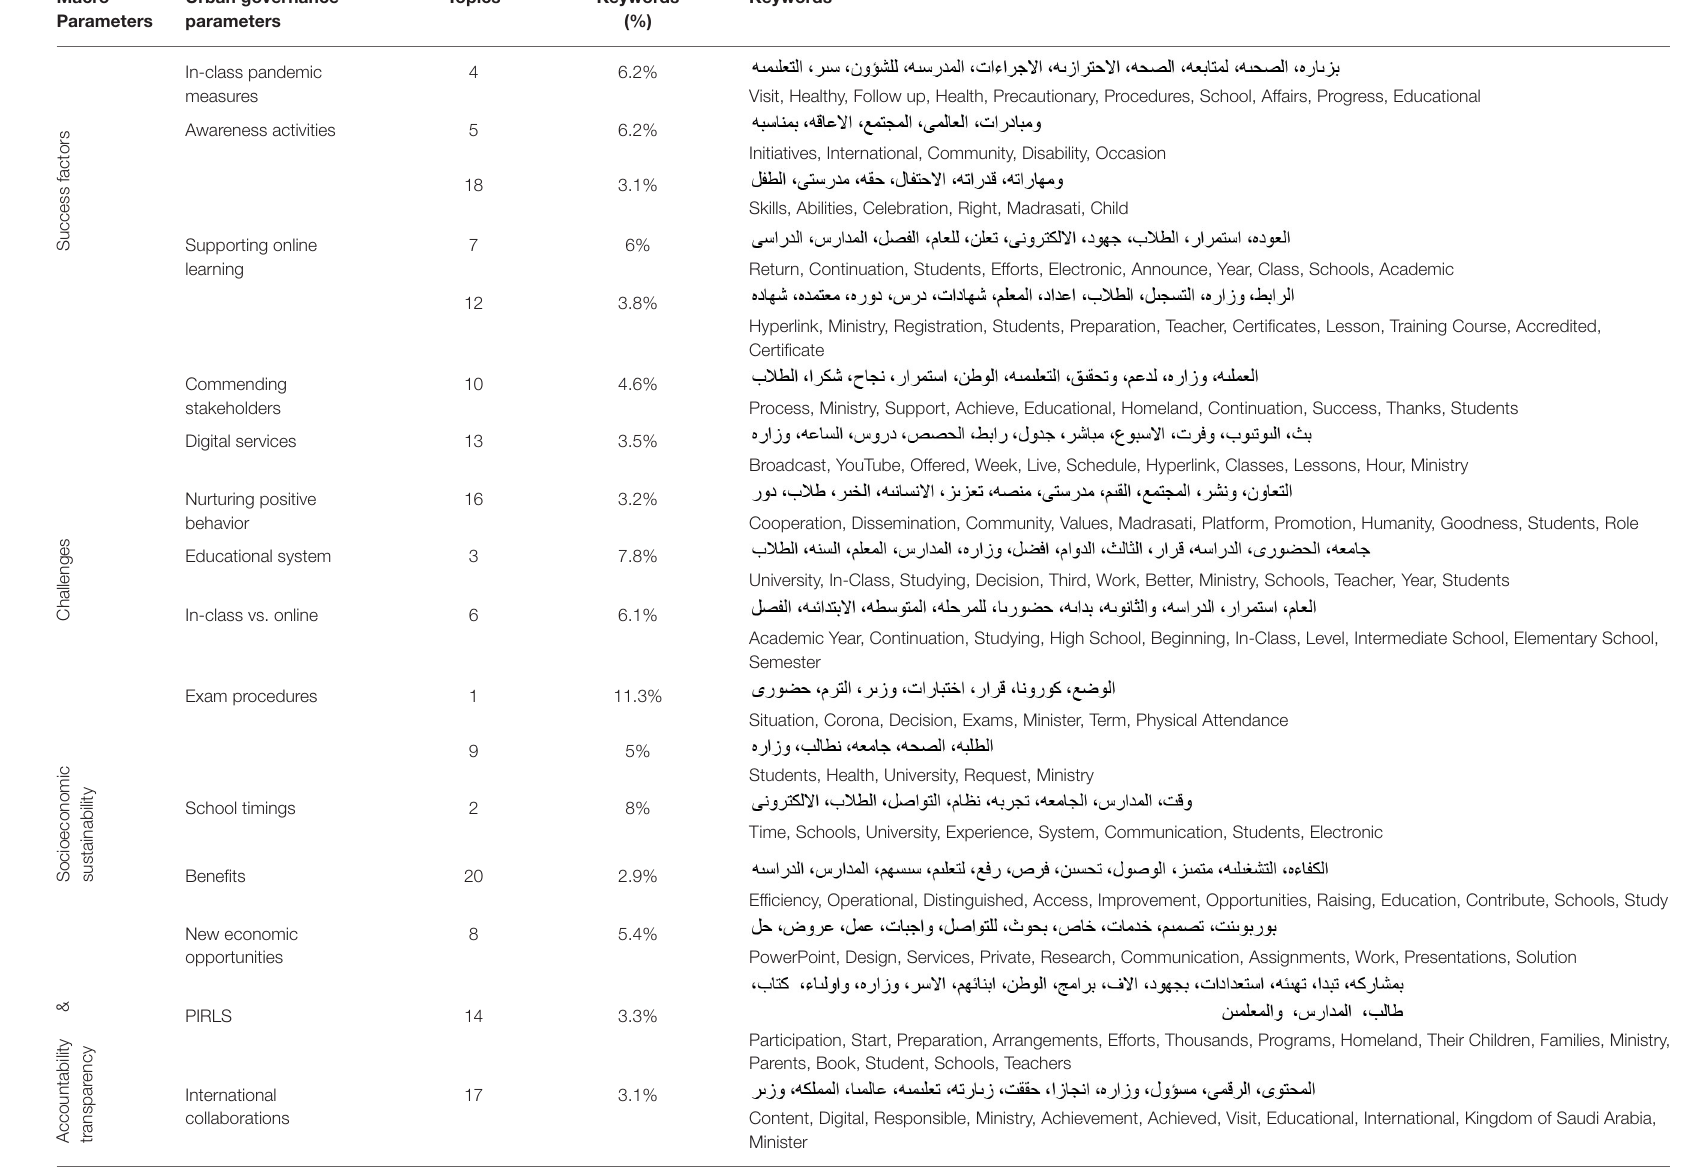
TABLE 2 | Urban governance parameters (online learning during COVID-19, October-December 2020). Macro-